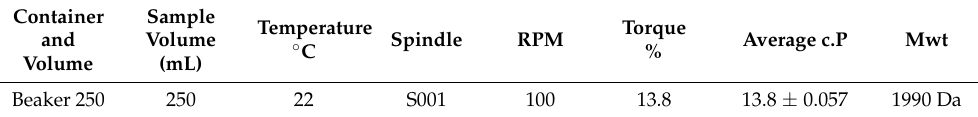
Table 1. Viscosity analysis of